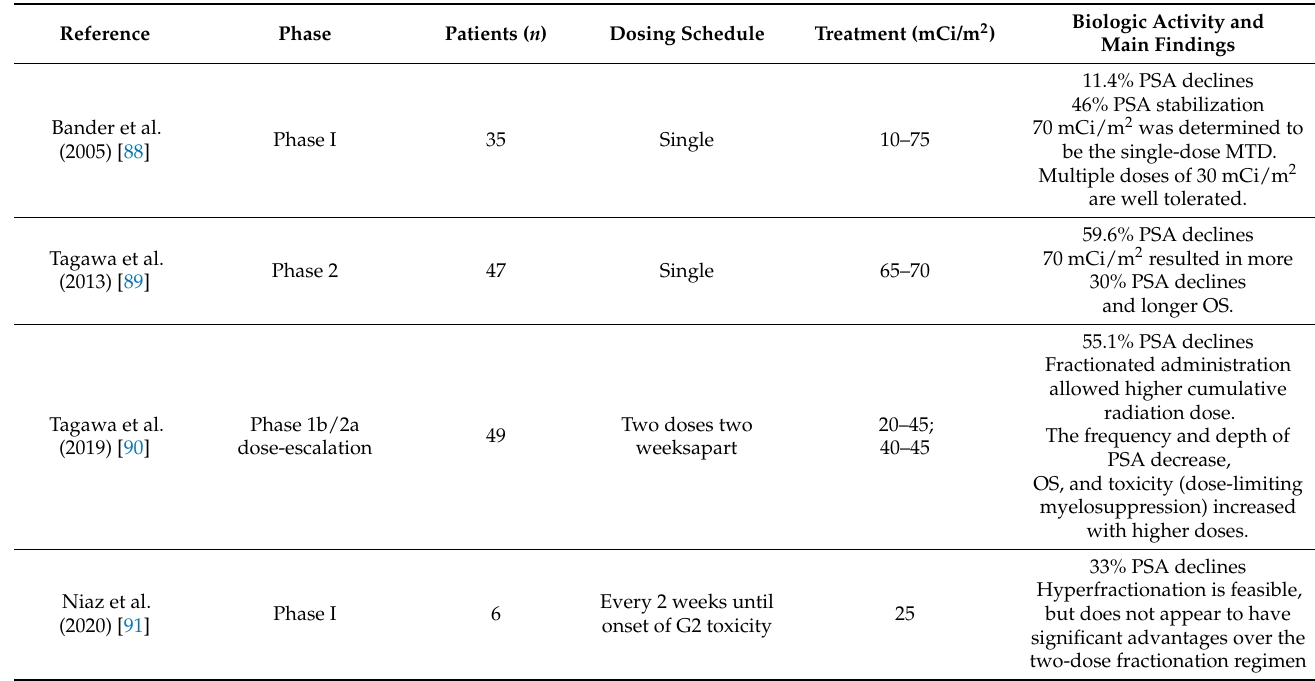
Table 3. Summary of all 177Lu-J591